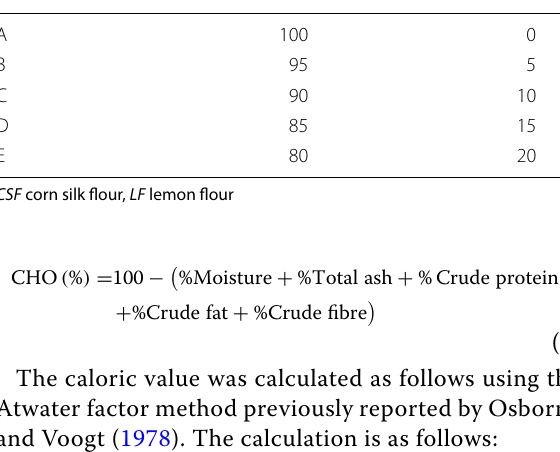
Table 1 Formulation of corn silk–lemon blends Sample